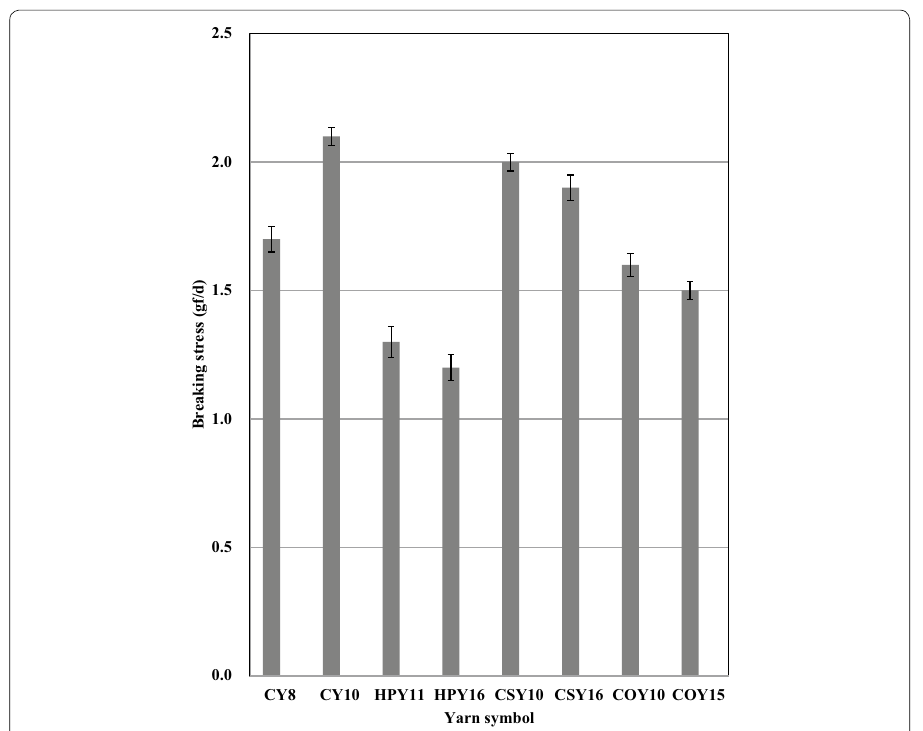
Fig. 1 Breaking stress of warp and weft yarn used for Hanji denim